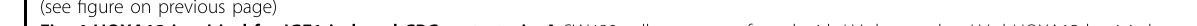
Fig. 4 HOXA13 is critical for IGF1-induced CRC metastasis. A SW480 cells were transfected with LV-shcontrol or LV-shHOXA13 lentiviral vectors and then treated with or without IGF1 (50 ng/mL, 24 h). Next, the HOXA13 protein expression was analyzed by western blotting. B Transwell assays demonstrated that IGF1 treatment increased the migratory and invasive abilities of SW480 cells, while HOXA13 knockdown reduced these capabilities of SW480 cells. C SW480 cells were transfected with lentiviral vectors to construct IGF1-overexpressing SW480 cells (SW480-IGF1), and HOXA13 expression was further knockdown via lentiviral transfection in SW480-IGF1 cells. IGF1 and HOXA13 expression in the indicated cell lines was examined by western blotting. D Transwell assays revealed that overexpression of IGF1 enhanced the migratory and invasive capabilities of SW480 cells, while HOXA13 knockdown impaired the enhanced migratory and invasive abilities of SW480-IGF1 cells. E In vivo liver metastatic assays. Four stable cell lines were injected into the spleens of nude mice ( n = 10 mice per group). Representative bioluminescent imaging, intensity of bioluminescence signals, incidence of liver metastasis, liver tissues ’ HE staining, number of metastatic liver nodules, and overall survival times in each group were shown. The scale bars represent 1 mm (low magni fi cation) and 100 μ m (high magni fi cation). F In vivo lung metastatic assays. Four stable cell lines were injected into the tail veins of nude mice ( n = 10 mice per group). Representative bioluminescent imaging, intensity of bioluminescence signals, incidence of lung metastasis, lung tissues ’ HE staining, number of metastatic lung nodules, and overall survival times in each group ( n = 10) were shown. The scale bars represent 1 mm (low magni fi cation) and 100 μ m (high magni fi cation). * P < 0.05, ** P < 0.01. Data are displayed as the mean ± s.d.